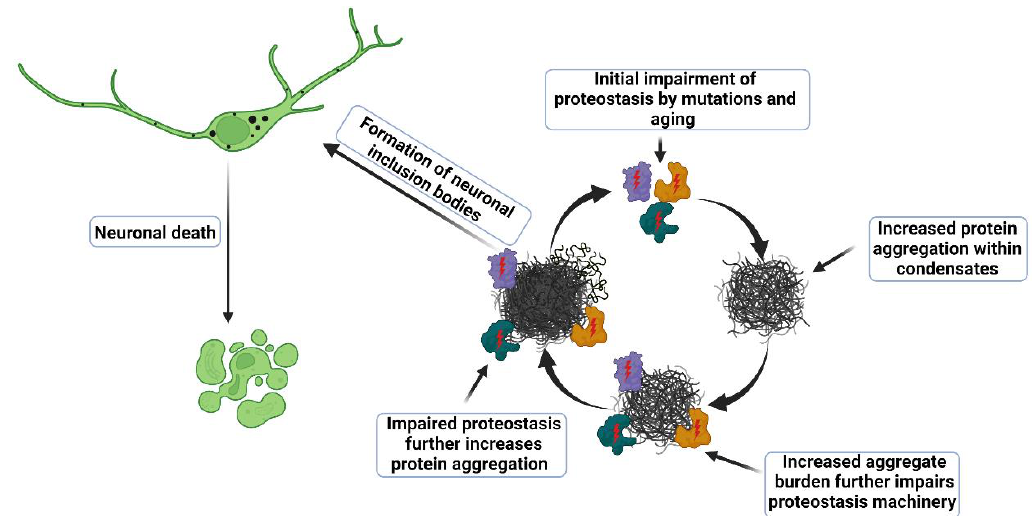
Figure 2. Model for dysregulated proteostasis in ALS pathogenesis. Impaired proteostasis by ALS- causing mutations, is aggravated by a decline in proteostasis capacity with aging [2], reducing neu- ronal capacity for handling misfolded proteins. Mutations in genes involved in protein degradation (e.g., VCP, UBQLN2, p62) may impair UPS function directly. C9ORF72-associated dipeptides inhibit the proteasome [92,93]. In addition, excess aggregation of specific mutated proteins (e.g., TDP43, FUS, SOD1, C9ORF72) exhaust and derail UPS function [94,95]. Supersaturated proteins aggregate and further contribute to proteostasis impairment. As a result of this vicious cycle, coaggregation of the neuronal proteome occurs in inclusion bodies.